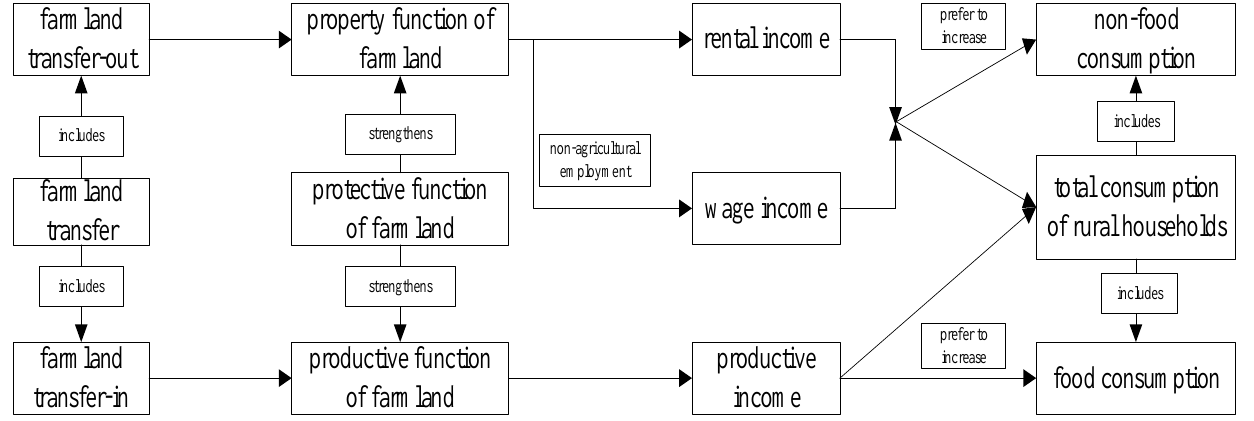
Figure 2. Analytical framework of the impact of farmland transfer on rural household consumption.